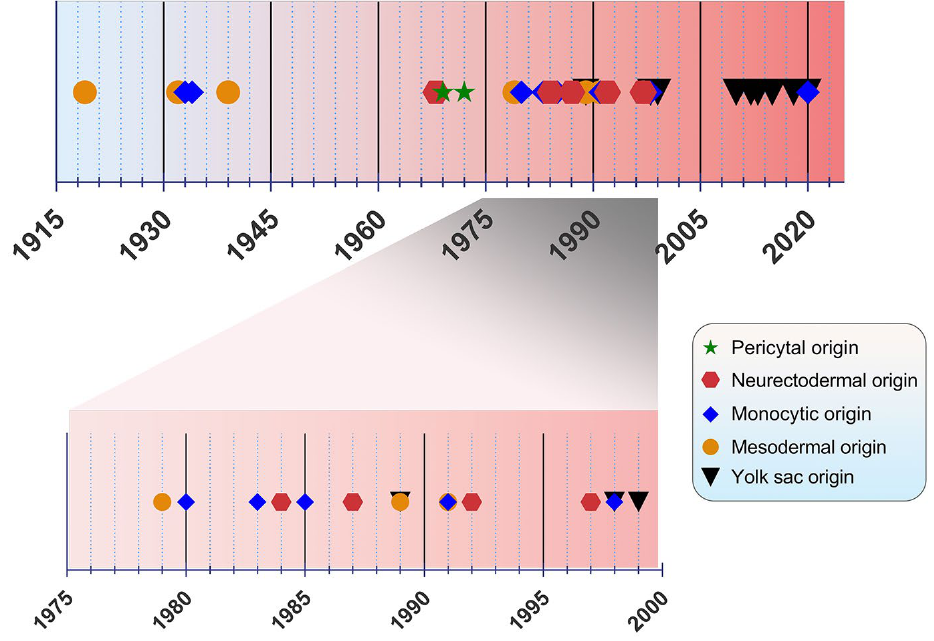
Figure 1. Timeline view of microglial origin since their discovery by Río Hortega.